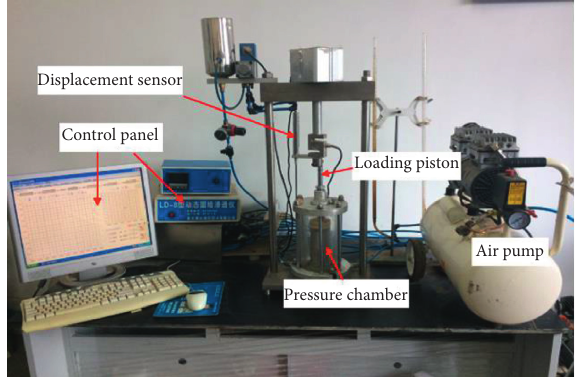
Figure 1: Photograph of the cyclic loading system.